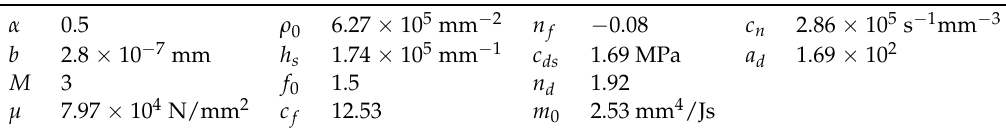
Table 2. Model parameter values. Fitted by least squares optimization to the hot torsion test data of Roucoules et al. [29].